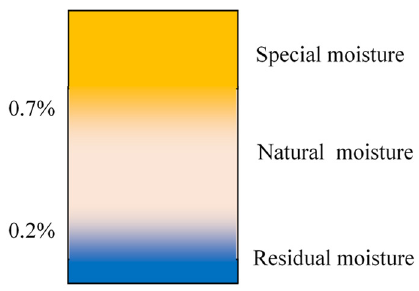
Figure 1. Ranges of filament moisture.